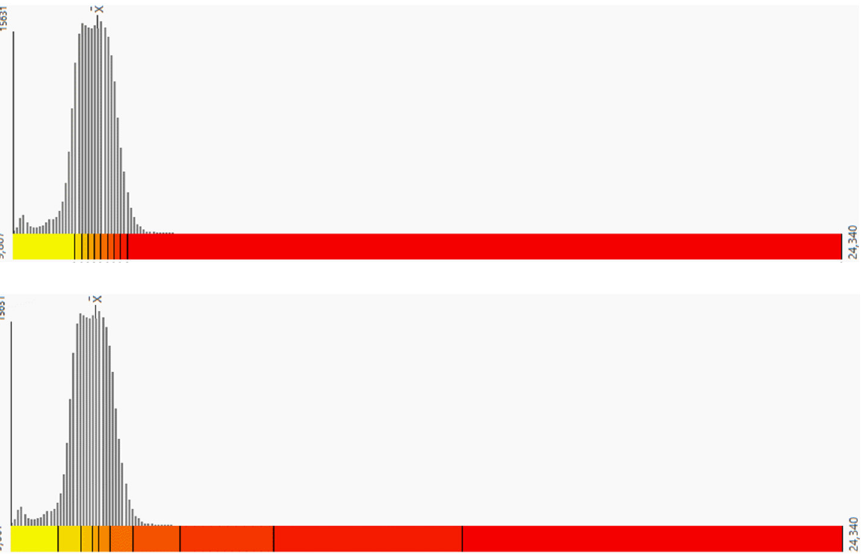
Figure 1. Comparison of the class breaks (tics at the bottom) for quantile ( top ) and GIC ( bottom ) methods for the blue band of a Landsat-8 image. The bar charts are the histogram of the image.